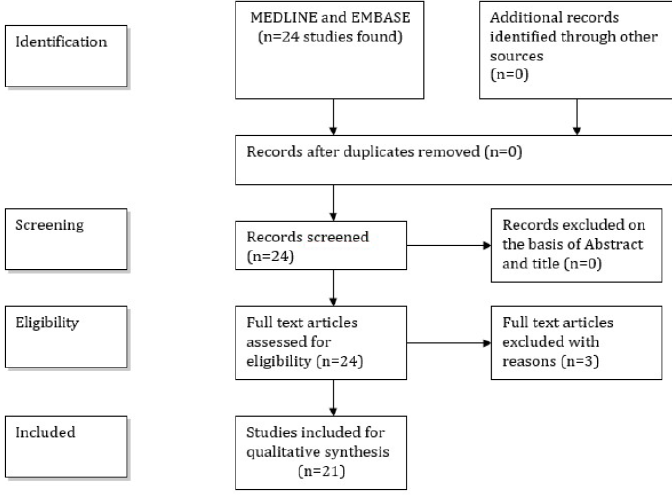
Figure 1. Flow-chart showing the selection/inclusion